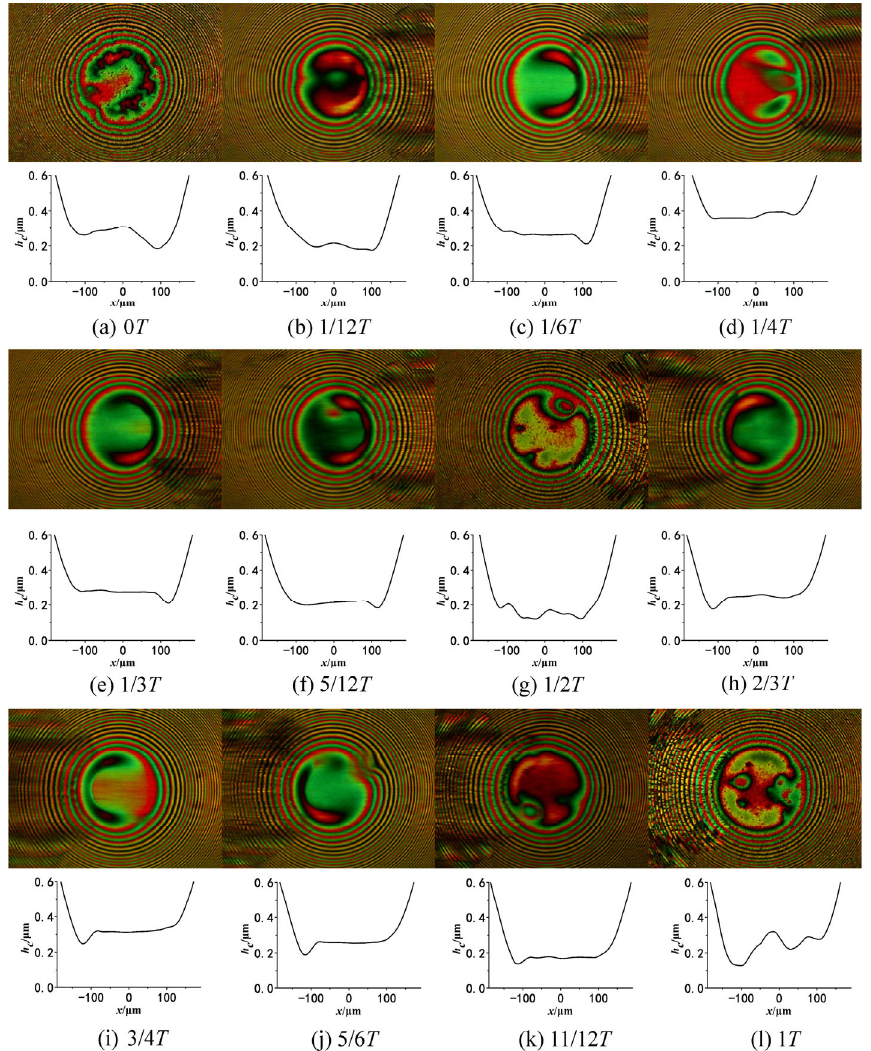
Fig. 20 Interferograms and midsection film thickness during 1st cycle under pure rolling reciprocating motion ( v max = 0.1 m/s, w = 15 N, T = 0.5 s, L = 12.5